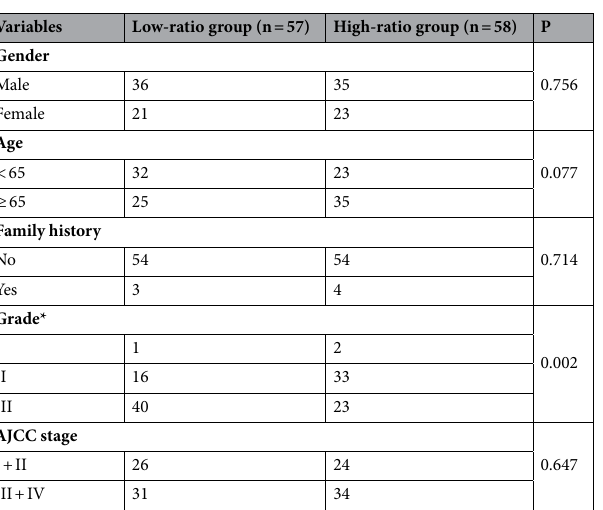
Table 2. Comparison between Low and High IL-6/IL-10 mRNA expression ratio Group. *Fisher exact test.